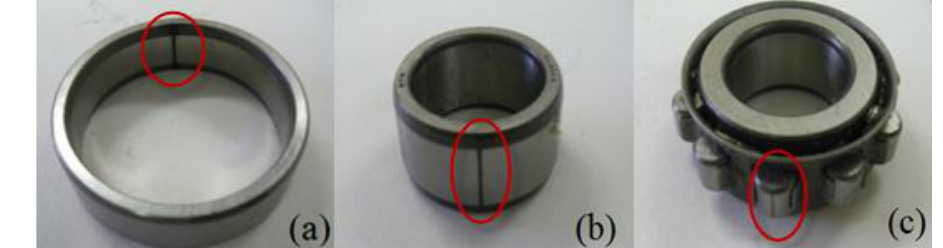
Figure 10. Bearing defects: ( a ) outer-race defect, ( b ) inner-race defect, and ( c ) roller element defect.